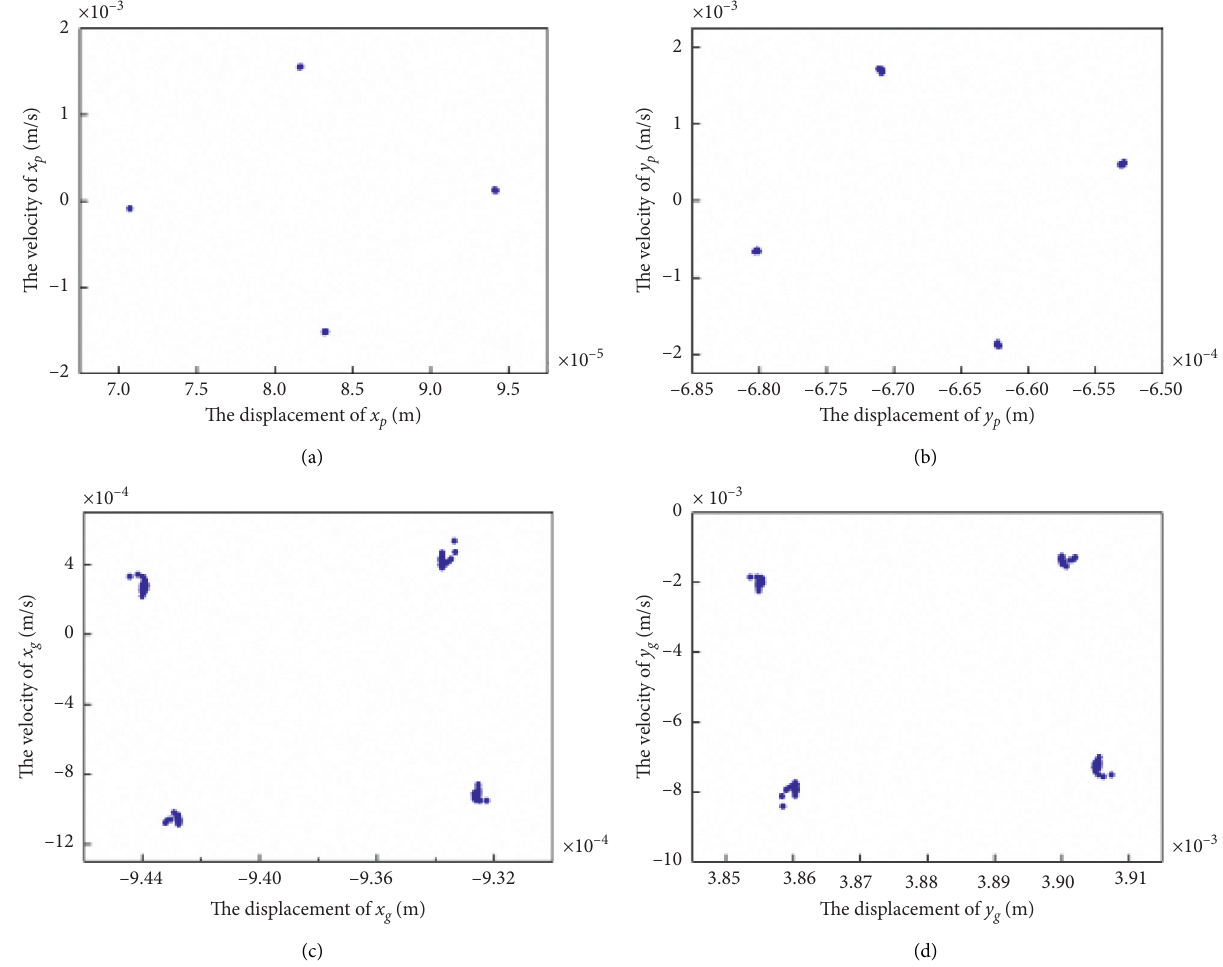
Figure 18: The Poincare mapping at i � 4. (a) The driving gear in x direction. (b) The driving gear in y direction. (c) The driven gear in x direction. (d) The driven gear in y